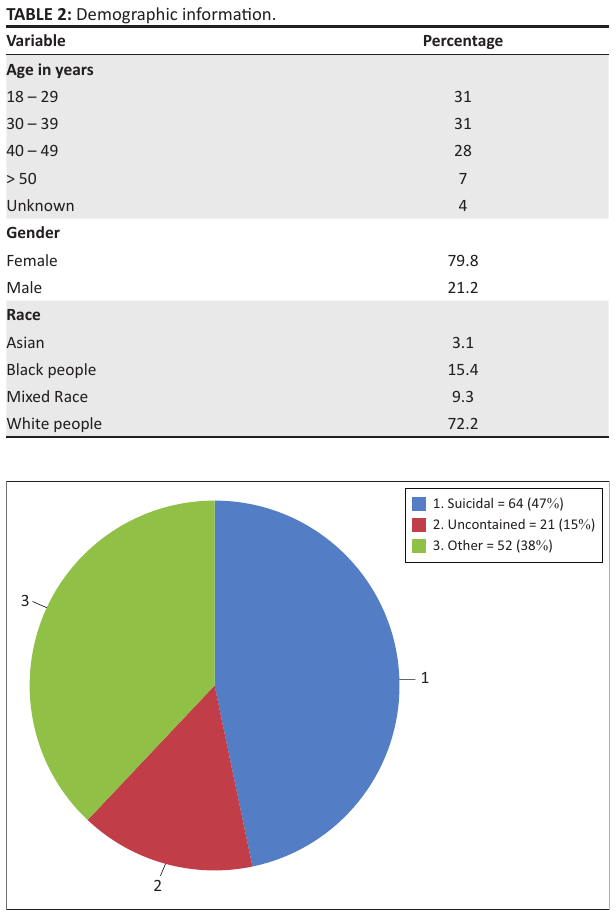
FIGURE 1: Reasons for admission of patients with borderline personality disorder admitted to the acute psychiatric unit at Helen Joseph Hospital during 2010.